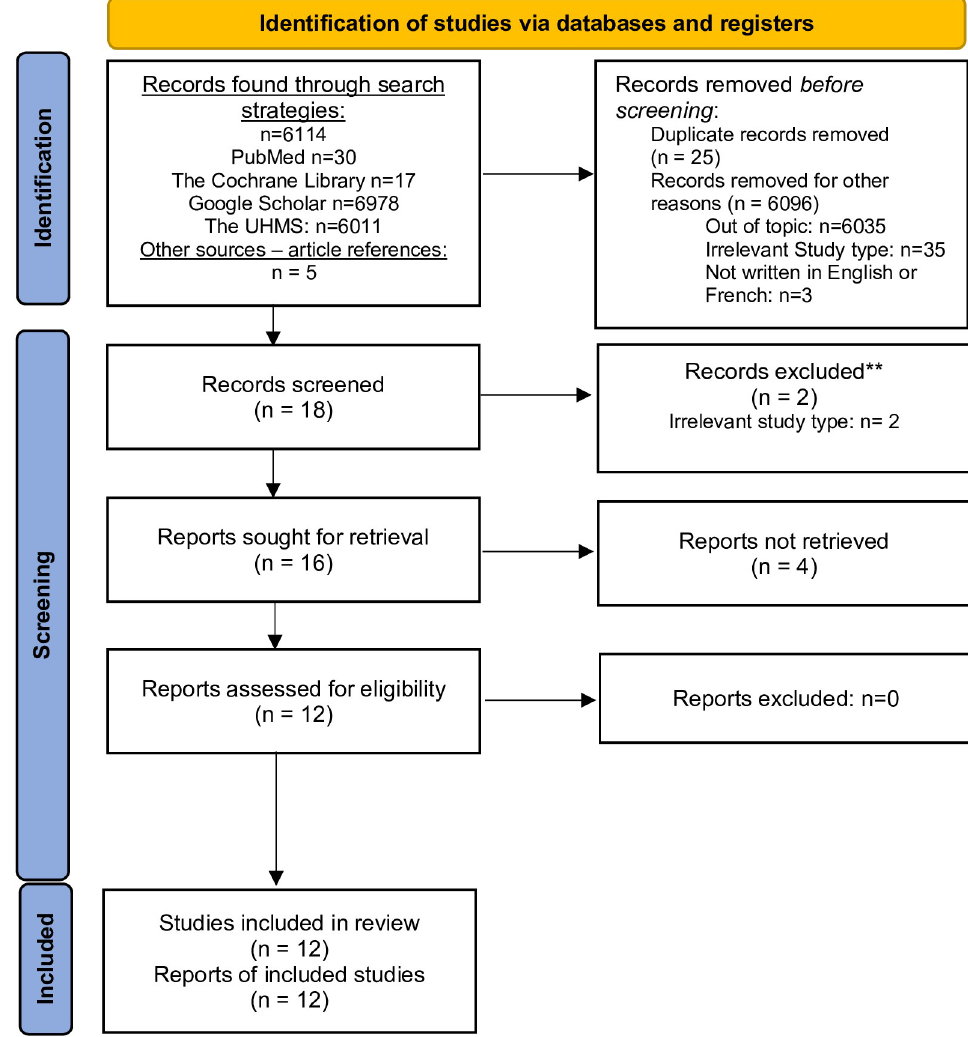
Fig 1. Flow-chart of the studies retained for the assessment of effectiveness of hyperbaric oxygen therapies in children with CP (primary objective).